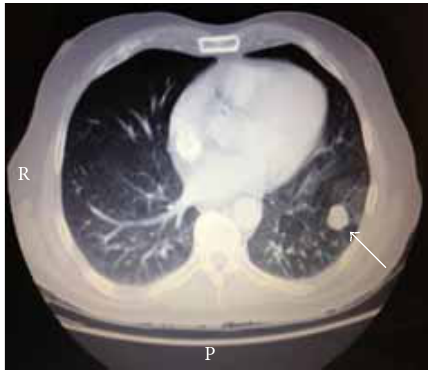
Figure 4: Staging CT scan showed a left perirectal soft tissue mass which is 2.0 × 2.2 cm in